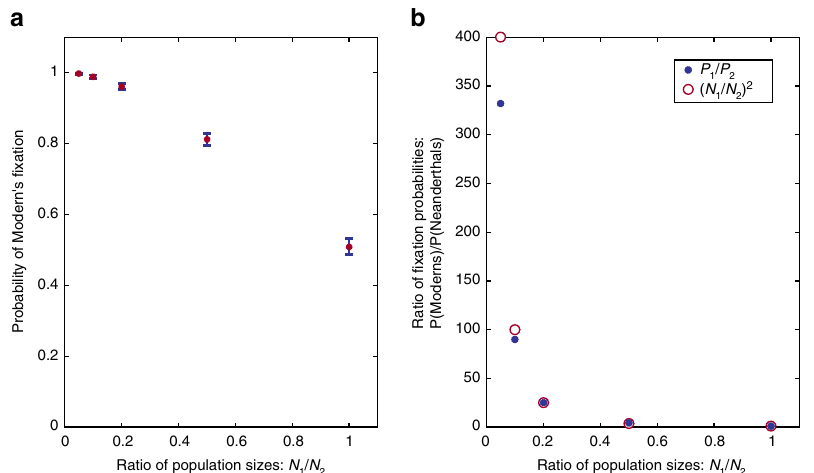
Fig. 3 Time trajectories of separate simulation runs. Number of bands of Moderns in Europe over time in nine randomly selected simulation runs a – i , with N = 500 bands in Europe, and migration probability from Africa to Europe, M 1 yellow circles denote, respectively, the last time that the Moderns and that the Neanderthals made up at least 10% each of the hominid population in Europe. Many trajectories, particularly in the fi nal phase leading to Modern ’ s fi xation, are highly directional